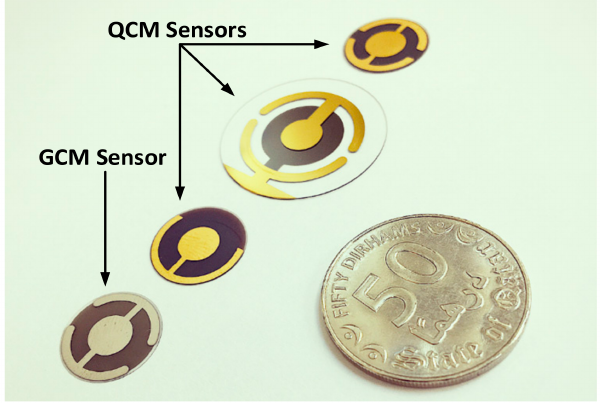
Figure 1. Sample commercial GCM and QCM